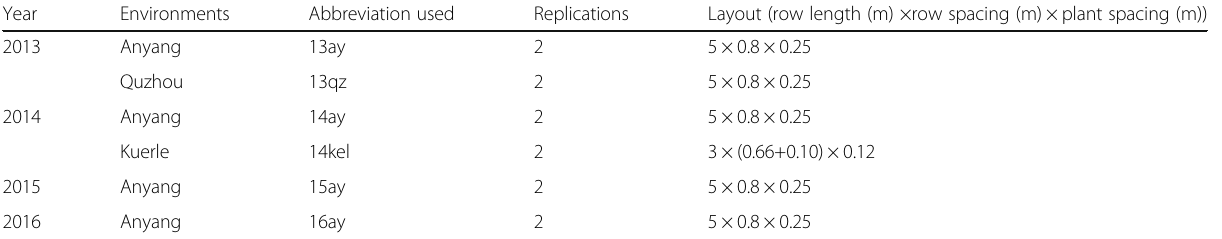
Table 1 Details of seven environments used to evaluate 231 F 6:8 RIL individuals and their parents Year